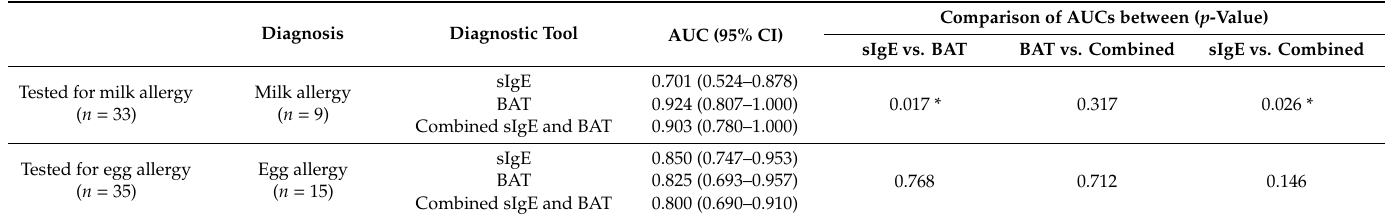
Table 4. Diagnostic performance of allergy tests in milk and egg allergy for patients with